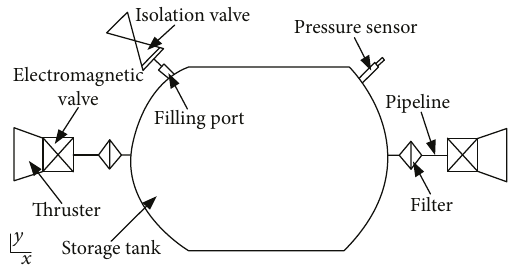
Figure 1: Propulsion system